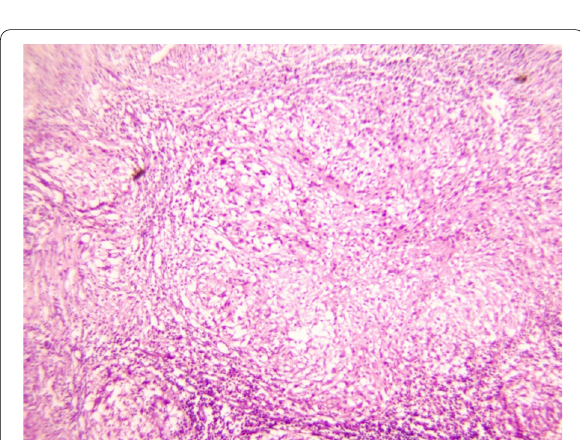
Fig. 4 Photomicrograph showing granulomatous inflammation in testicular tissue, featuring caseous necrosis (H&E stain,